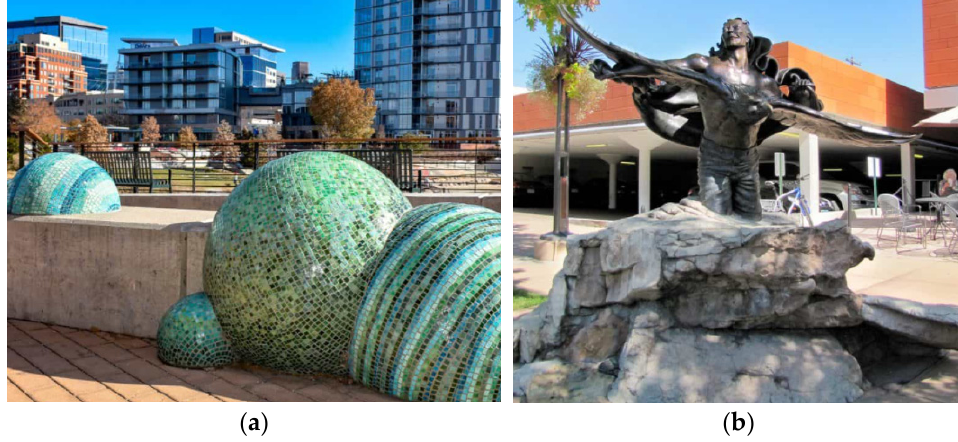
Figure 35. ( a ) GFRC “Sing and Glide” sculpture in Confluence Park in Denver, USA [139]; ( b ) GFRC base of “I Too Know The Eagle” sculpture in Cherry Creek North in Denver, USA [139].